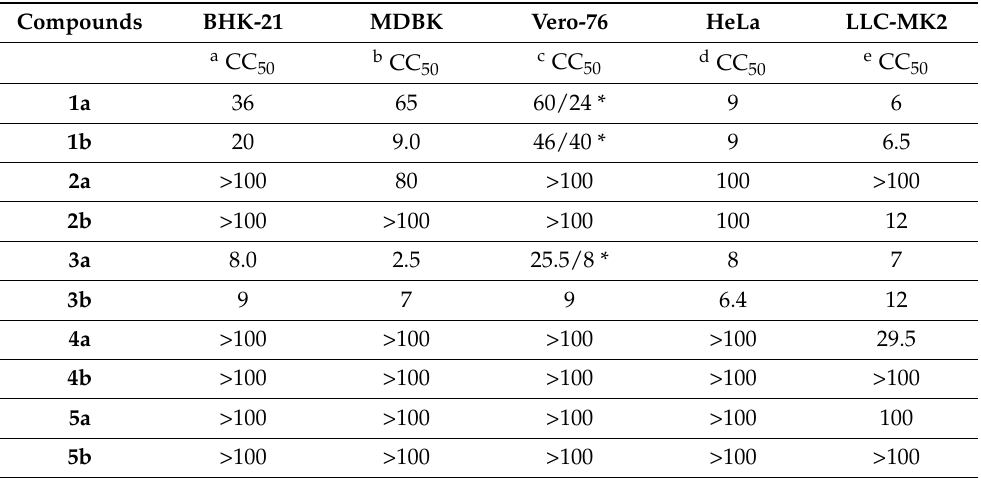
Table 2. Cytotoxicity of benzimidazole (BIZ) derivatives against selected cell lines ◦ . Compounds BHK-21